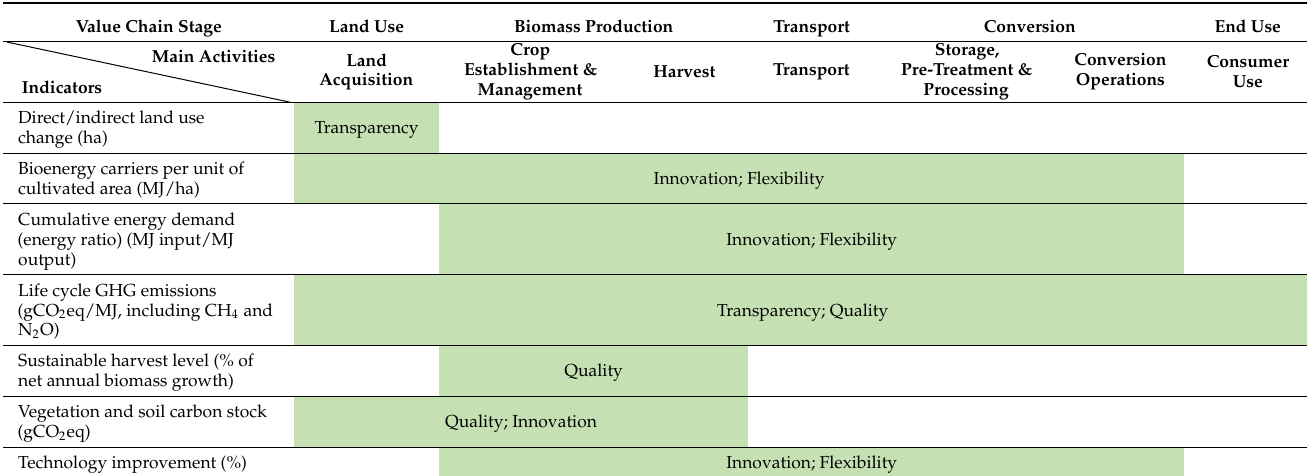
Table 1. Indicators and competitive priorities per value chain stage (relevance of indicator per value chain stage illustrated by green